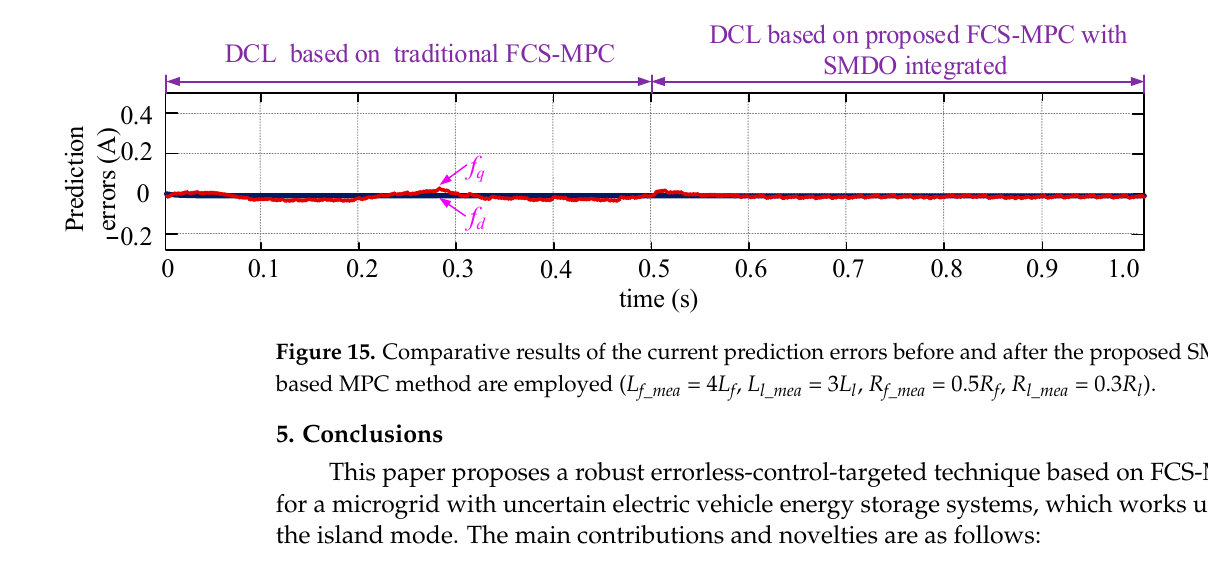
Figure 14. Control performance of the proposed DCL method with parameter mismatch considered (the SMDO works, L f_mea = 4 L f , L l_mea = 3 L l , R f_mea = 0.5 R f , R l_mea = 0.3 R l ).